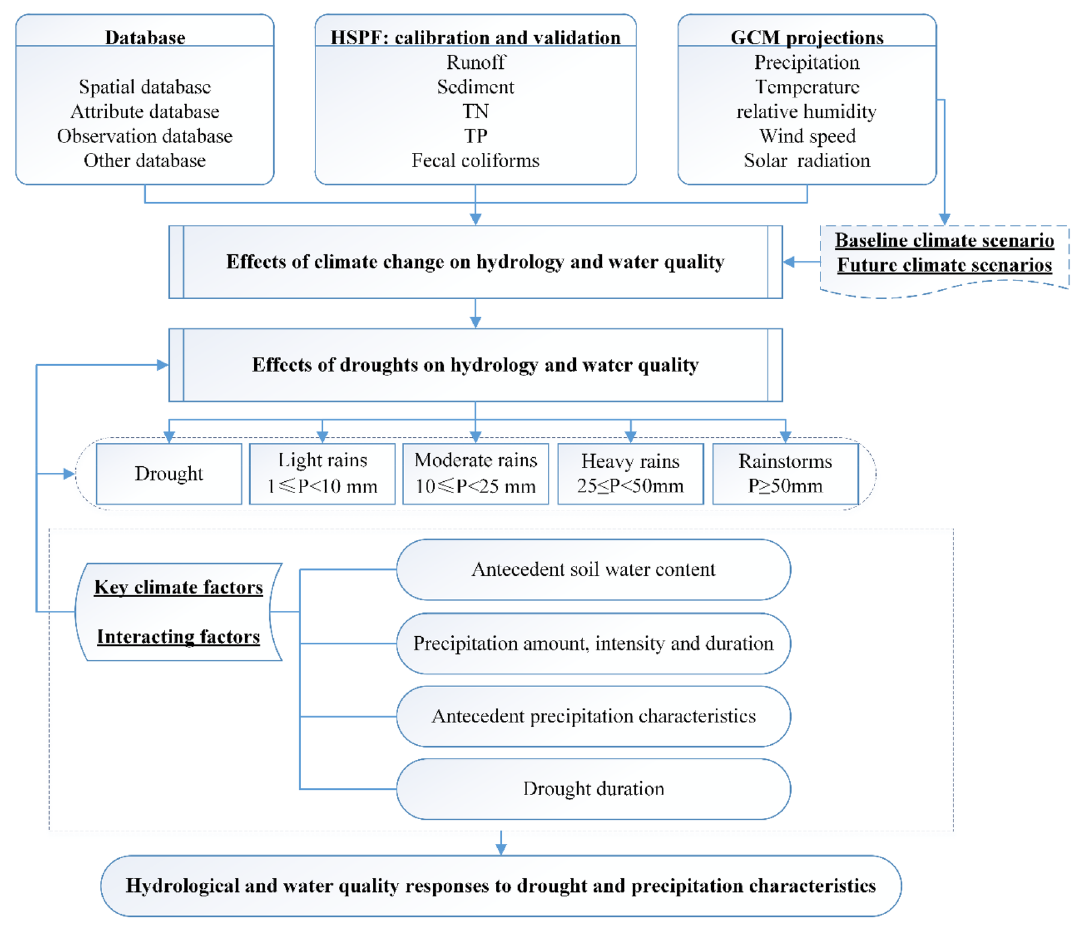
Figure 1. The framework for seeking potential impacts of extreme precipitation and drought on watershed hydrology and NPS meteorological forcing such as hourly and/or daily time series of precipitation, maximum and minimum air temperature, relative humidity, potential evapotranspiration (PET), solar radiation, wind speed, and cloud cover. Table S1 in the Supplementary Material shows the required data for model setup. Based on information about watershed topography and land cover, the HSPF divides a watershed into three hydrologic units: pervious land, impervious land, and stream channels. The HSPF contains various equations and parameters to simulate water balance and eventual disposition as well as transport and transformation of pollutants within streams and pervi- ous and impervious land segments 25 . Model calibration and validation were performed based on the observed data during 2014–2015, combined with an automatic calibration program (the Model-Independent Parameter Estimation (PEST) program) and the Bacterial Indicator Tool for parameter adjustment. More details of the model description, data availability, and calibration and validation of hydrological and water quality processes in the TMC (Tables S2 to S5 in the Supplementary Material) were given in a previous study by the authors 32 . The statistical metrics (coefficient of determination ( R 2 ) and Nash–Sutcliffe efficiency ( Ens )) indicated satisfac- tory performance of the HSPF model in simulating streamflow and water constituents in the study watershed (Table S5 in the Supplementary Material). Climate scenarios. Extreme climate projections from 2020 to 2099 were obtained from five GCMs that are recommended in the Inter-Sectoral Impact Model Inter-comparison Project (ISI-MIP), including GFDL- ESM2M, HadGEM2-ES, IPSLCM5A-LR, MIROC-ESM-CHEM, and NorESM1-M (Table S6 in the Supplemen- tary Material), based on the Coupled Model Intercomparison Project 5 (CMIP5). The scenario 8.5 representative concentration pathway (RCP 8.5) was selected because it has the highest levels of forcing and the largest prob- ability of climate change at the end of the twenty-first century according to the development styles of population, technology, and economics 33 to reveal potential extreme effects on watershed systems. To reduce systematic biases in models, simulated climate datasets were corrected by a distribution-based bias-correction method, which was given in Hempel et al. 34 . The probability distributions of observations and bias-corrected simulations during 1960–2005 are shown in Fig. S1 in the Supplementary Material. Although the probability distributions of precipitation remained imperfect, a substantial harmonisation was achieved. For temperature the values showed very good agreement. These results verified the applicability of GCMs.